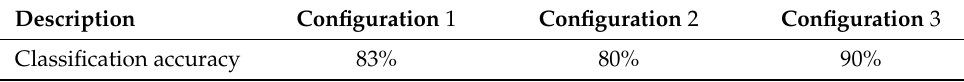
Table 5. Classification accuracy level of different walking